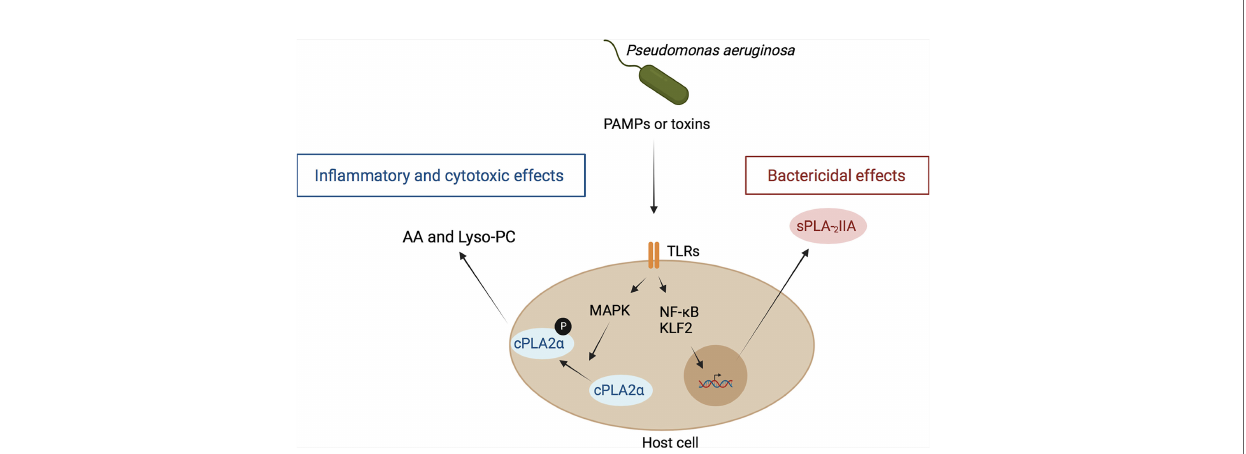
FIGURE 1 | Role of host PLA fl ammation and antibacterial defense during P. aeruginosa infection. P. aeruginosa interacts with host cells through the binding of 2 in in PAMPs of this bacterium, mainly LPS and fl agellin to the host receptors TLR4 and TLR5, respectively, leading to NF-kB activation. In parallel, toxins, including ExoS, are also injected by this bacterium into host cells, leading to activation of the transcription factor KLF-2. Both processes result ultimately in the induction and secretion of